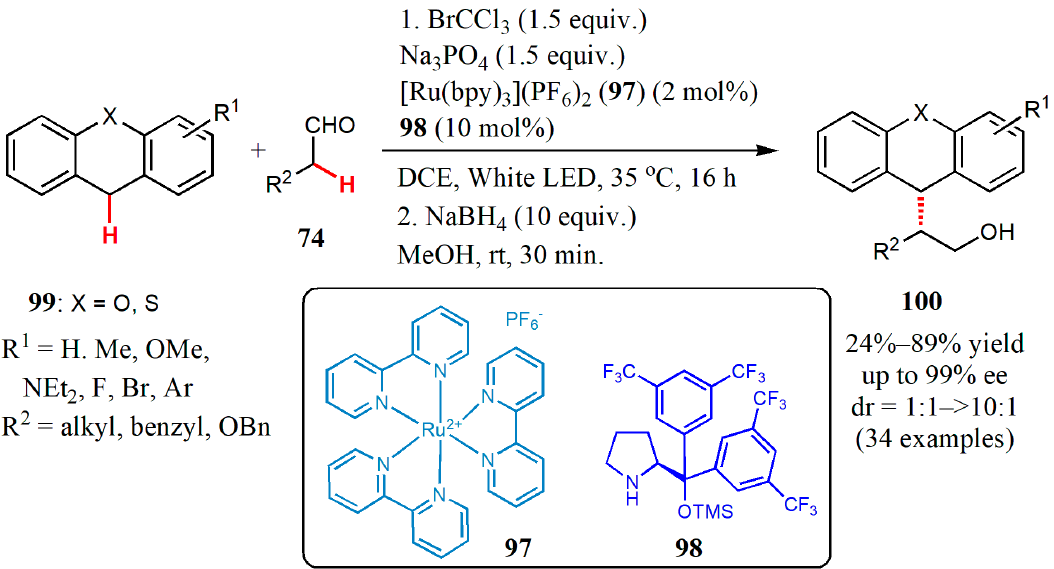
Figure 30. Asymmetric CDC of aldehydes with xanthenes by cooperative visible-light photoredox catalysis and organocatalysis.